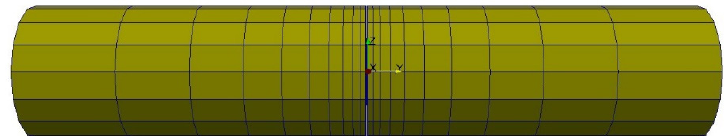
Figure 2: The FE model for the sharply notched shaft.